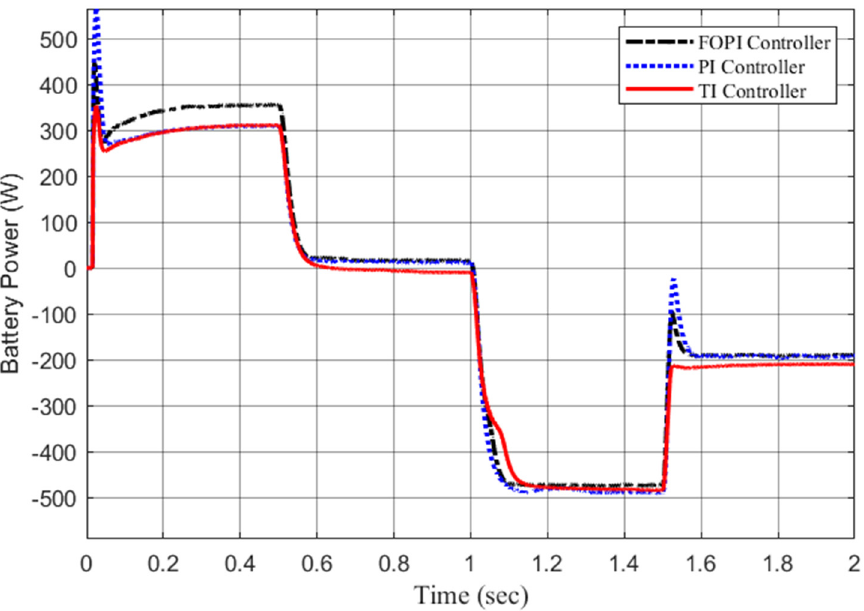
Figure 10. Response of battery power with varying irradiance and load conditions.